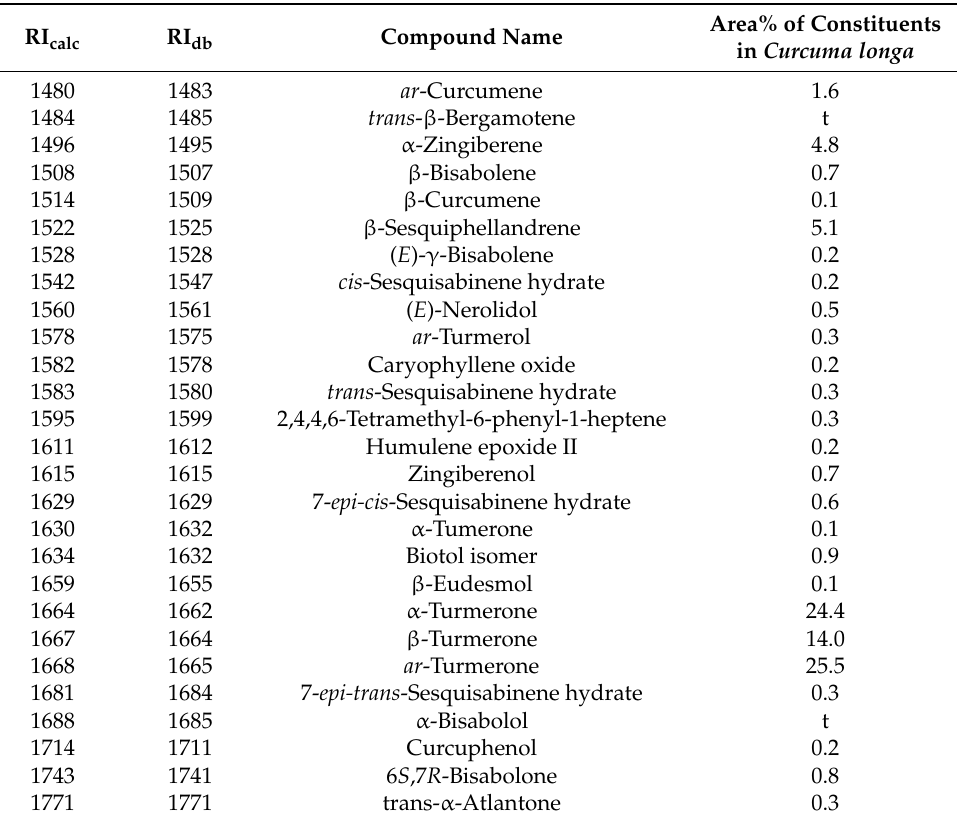
RI calc = Retention index determined with respect to homologous series of n-alkanes on a ZB-5 column. RI db = Retention index from the database [33,34]. ‘t’ indicate trace (< 0.05%). The chemical composition of C. aeruginosa , and C. zedoaria compositions are presented in Table 2. In the case of C. zedoaria essential oil, the total number of identified compounds was 98 and accounted for 81.55%. The most representative compounds werecurzerenone